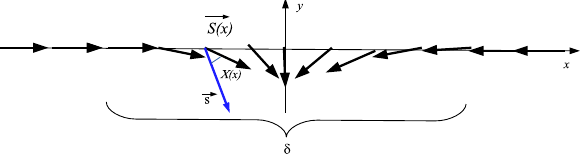
Figure 1. A schematic view of interaction among electron with the spins of the ferromagnetic domain wall of width δ . χ( x ) is the phase angle among electron spin with spin of the ferromagnetic